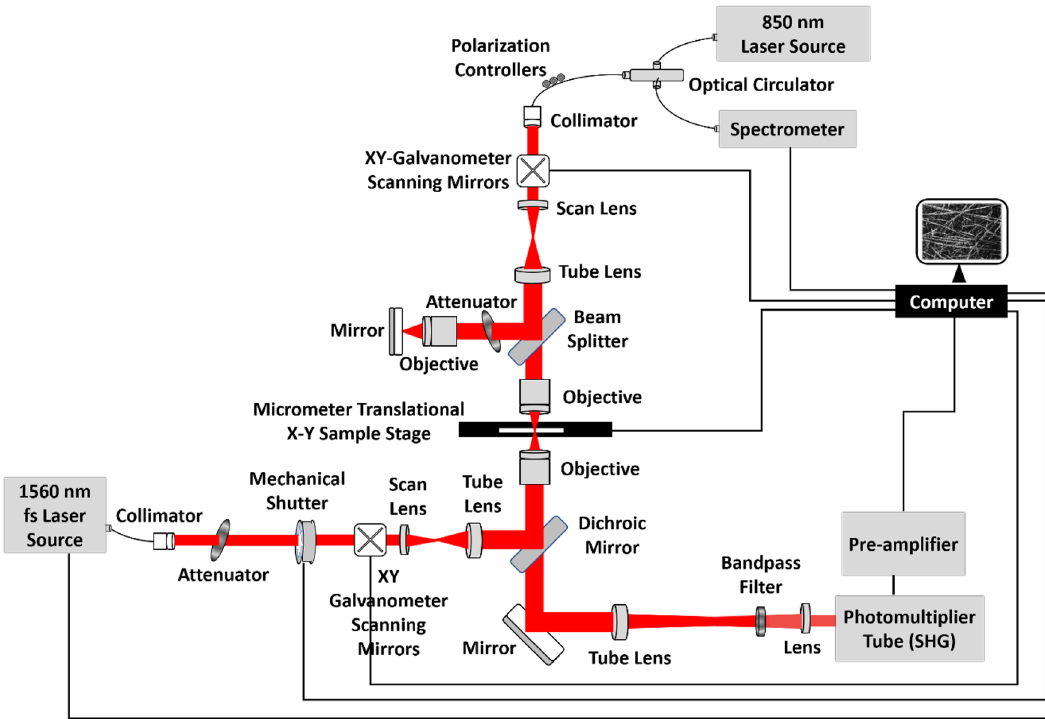
Figure 6. Schematic of the multimodal imaging system. Optical design schematic with the optical components used along with the MPM and OCM sources, detection components, and two-axes micrometer translational sample stage. Figure not drawn to